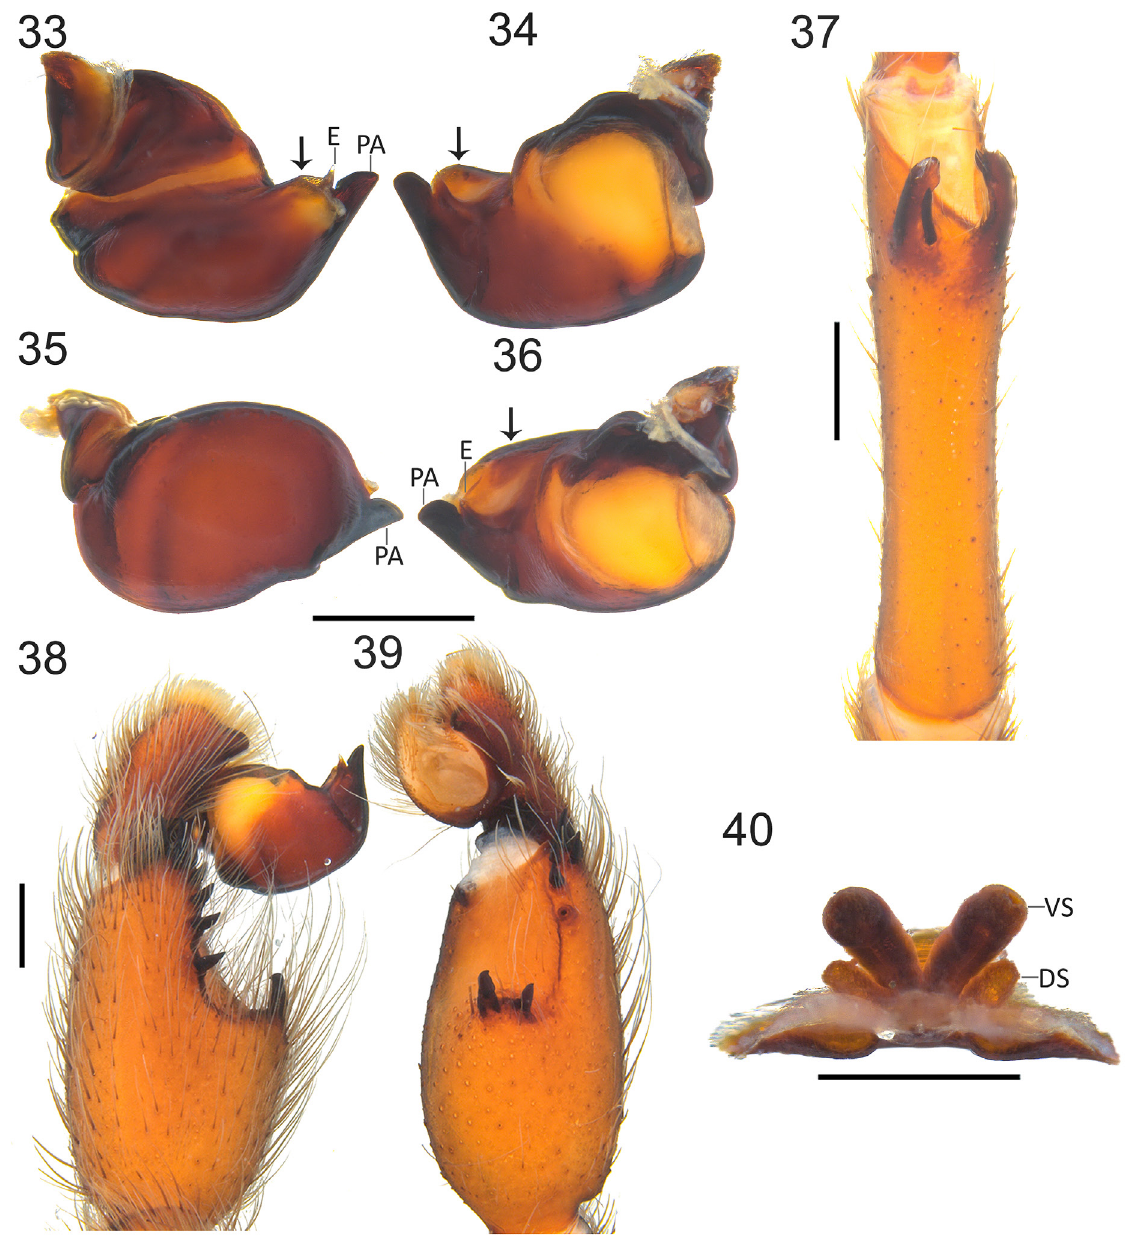
Figs 33–40 . Schismatothele caiquetia sp. nov. 33–39 . Holotype, ♂ (MZSP 28423). 33–36 . Palpal bulb, prolateral (33), retrolateral (34), ventral (35), and dorsal (36) views. 37 . Tibial spur, ventral view. 38–39 . Palpal tibiae, right (38), and left (39). 40 . Paratype, ♀ (MZSP 28424), spermathecae, ventral view. Abbreviations: E = embolus; DS = dorsal receptacle; PA = paraembolic apophysis; VS = ventral receptacle. Black arrows show the tegulum prolateral lobe. Scale bars = 0.5